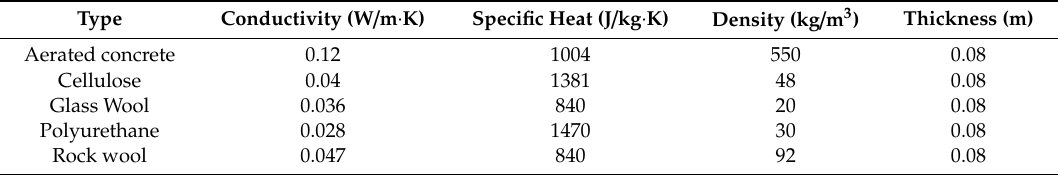
Table 6. Insulation materials and their